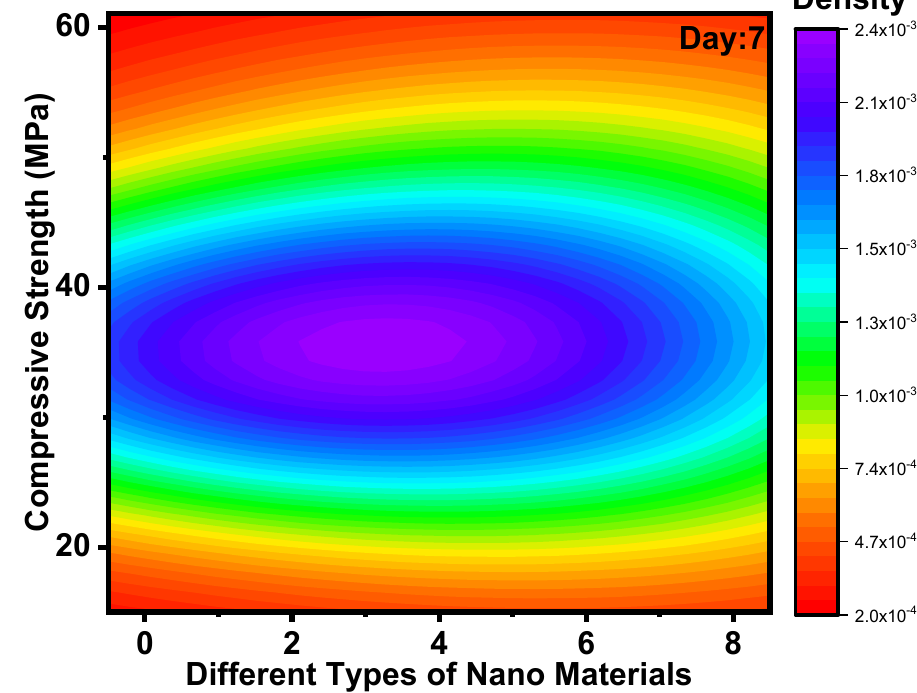
Figure 5. Kernel density plot for CS for day 7.